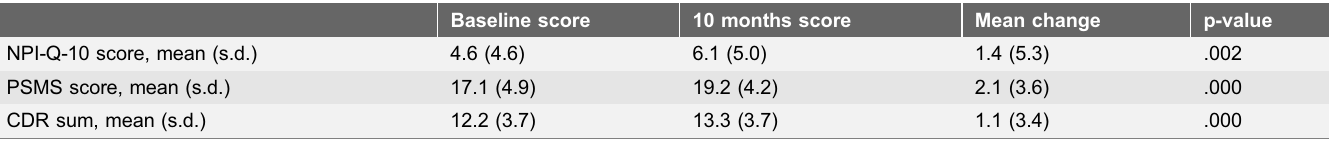
Table 4. Change in scores on Neuropsychiatric Inventory-10 Questionnaire (NPI-Q -10), the Physical Self Maintenance Scale (PSMS) and the Clinical Dementia Rating scale, sum of boxes (CDR), between baseline and 10 months follow-up (N 5 143). Baseline score 10 months score NPI-Q-10 score, mean